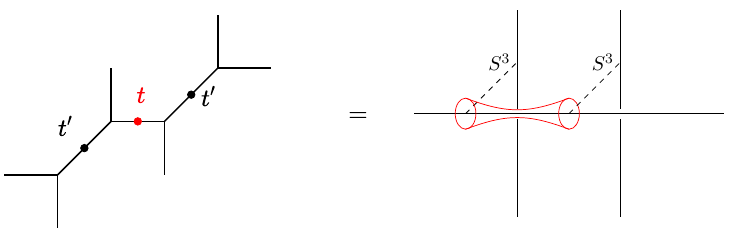
Figure 12 : Toric diagram for the partition function(wavefunction) Figure 18 . The dual thermal interpretation of the resolved conifold partition function is obtained by first introducing two S 2 with Kahler paremeter t 0 (left figure) and then applying a geometric transition to the deformed geometry on the right with branes on two S 3 . The worldsheets stretched between these branes describe open string loop